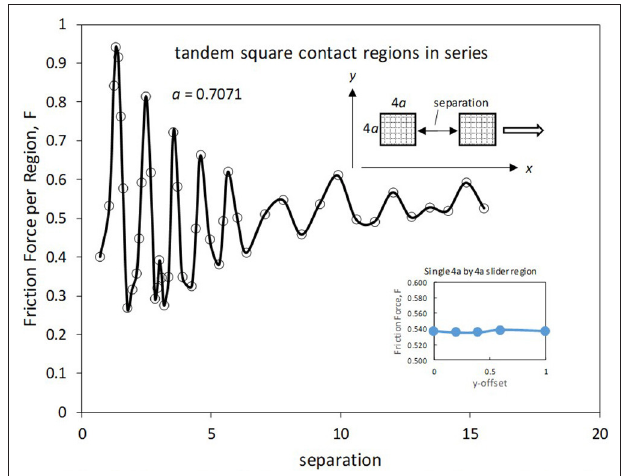
FIGURE 9 | Friction force vs. inter-slider separation for separation along x- axis. Inset shows the effect of slider offset for an isolated slider.